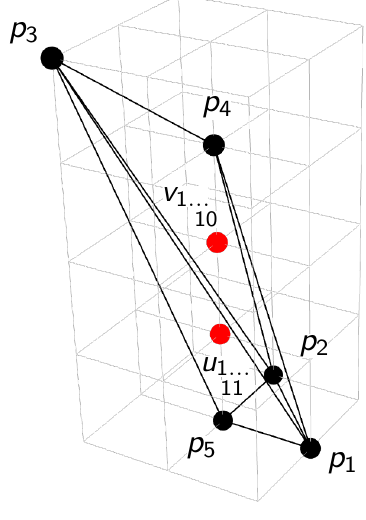
Figure 21 . Toric diagram of Y 3 , 4 ( CP 2 )